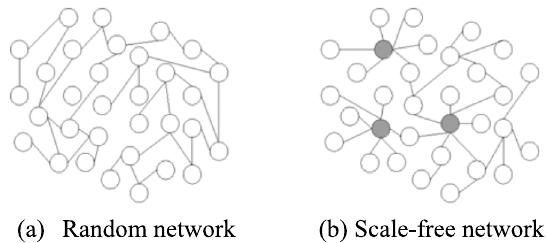
Fig. 2 The random network and scale free network a the random network is virtually homogeneous and follows the Poisson distribution. Nearly all nodes have the same number of links. b Scale-free network: An inhomogeneous network that exhibits power-law behavior. The majority of nodes have one or two links, but a few densely connected nodes, or "hubs," have many links.in the scale-free network, the largest hubs are highlighted with dark circles, nodes are presented with white circles